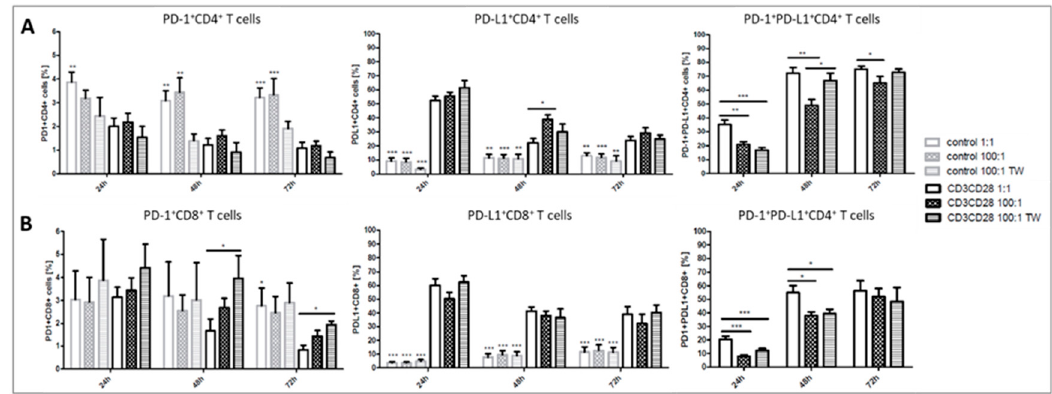
Figure 4. Flow cytometric analysis of the percentage of PD-1 and PD-L1 positive CD4+ ( A ) or CD8+ ( B ) T cells from healthy donors after 24, 48, and 72 h of culture. Cells were left untreated or stimulated with anti-CD3 and anti-CD28 antibody and cultured in a PLT: PBMC ratio of 1:1, 100:1 (direct contact), or 100:1 in Transwell Assays (TW). The number of PD-1+PD-L1+ T cells was not evaluable in unstimulated cultures and are not shown. Bars show mean + SEM of results from 20 healthy donors. * p ≤ 0.05; ** p ≤ 0.01; *** p ≤ 0.001; 1-way Anova with Tukey’s multiple comparisons test.